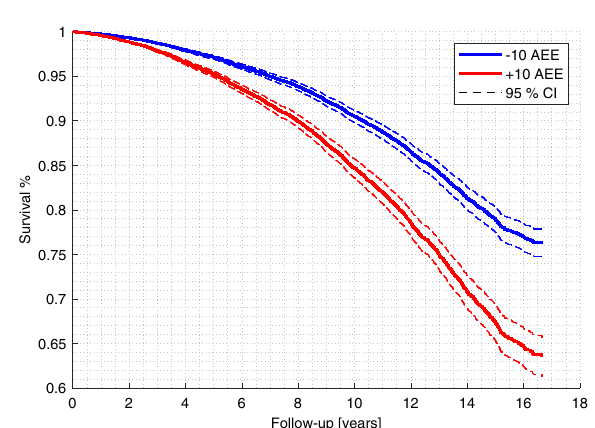
Fig. 4 Survival curve for all-cause mortality with an AEE varying ±10 years. The survival curve was generated for all data ( n = 9386, deaths = 3045) and model (e, Ensemble – Avg.) using the Cox proportional hazards model 3 shown in Supplementary Table 3. The 95% CI express the uncertainty in the modeled hazard ratio. AEE age estimate error, CI con fi dence